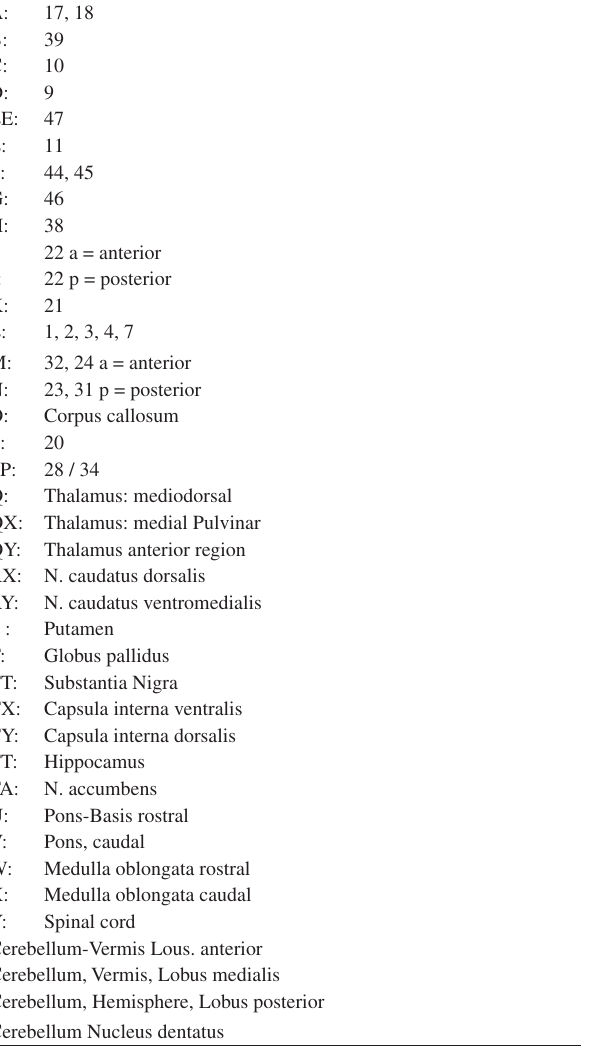
Table 2 - Definition of regions of interest in psychiatric disorders according to Brodmann. (Each region: 2 frozen samples and 1 formalin-fixed, paraffin-embedded